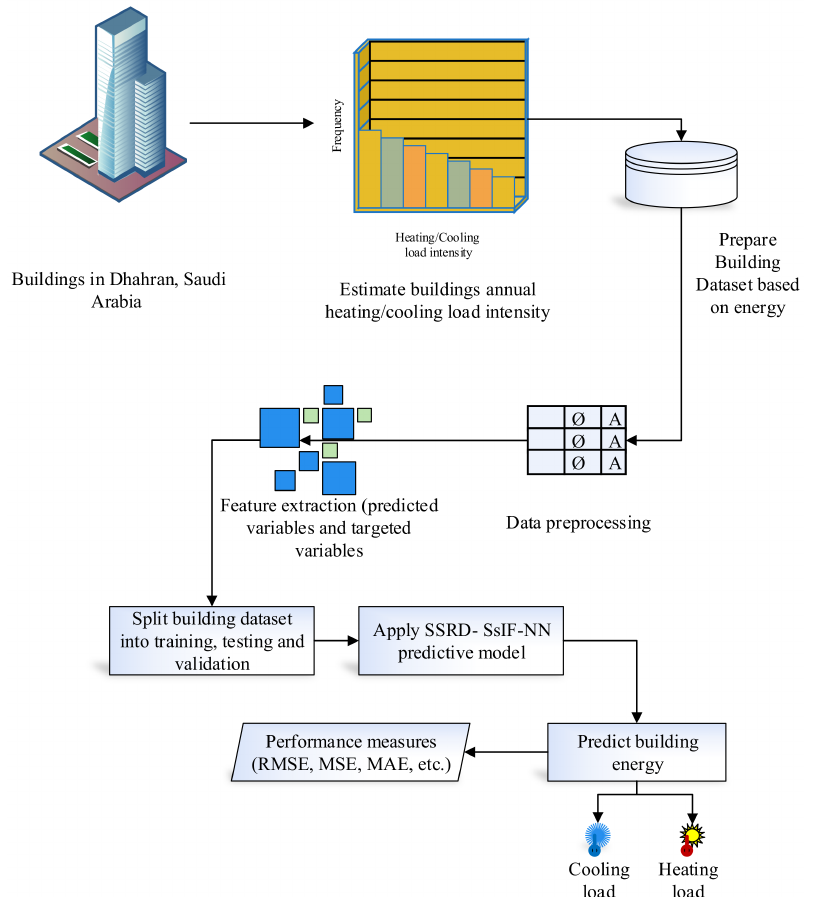
Figure 1. Proposed framework of the predictive